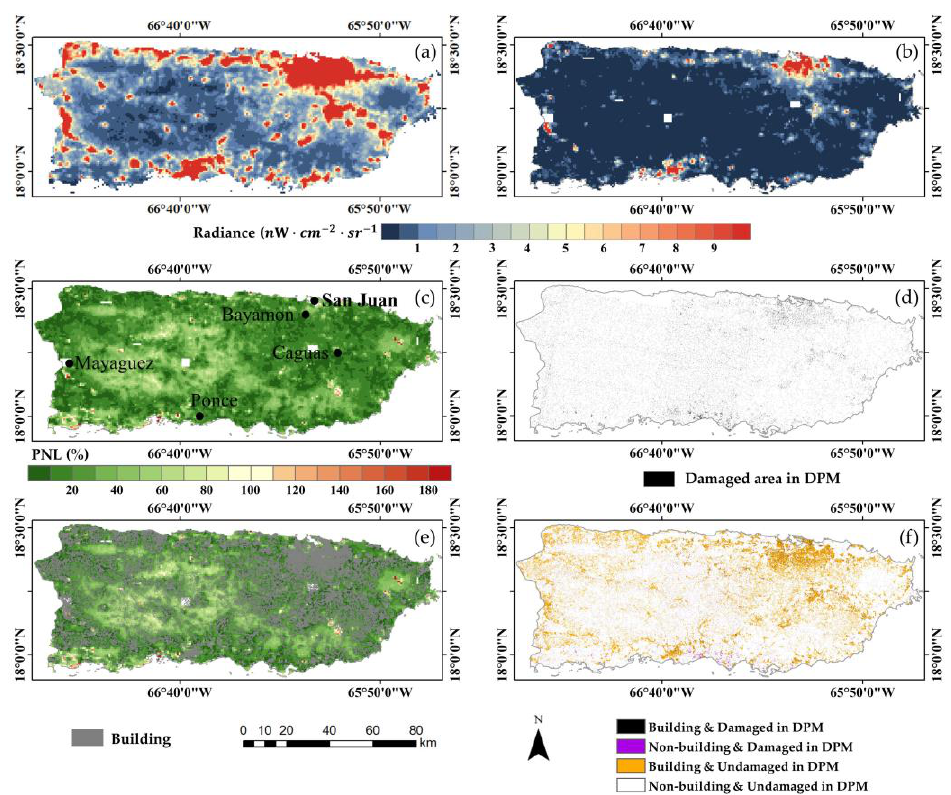
Figure 5. ( a ) The pre- and ( b ) post-storm averaging composite DNB images, ( c ) PNL image, ( d ) DPM image, ( e ) OSM building map combined with PNL image, and ( f ) DPM image compared with the building map of Hurricane Maria.